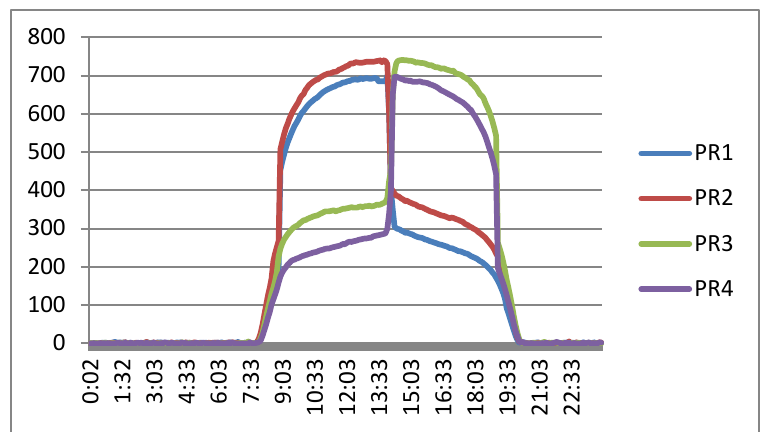
Figure 15. Evolution of the luminosity value obtained in the four PRs.